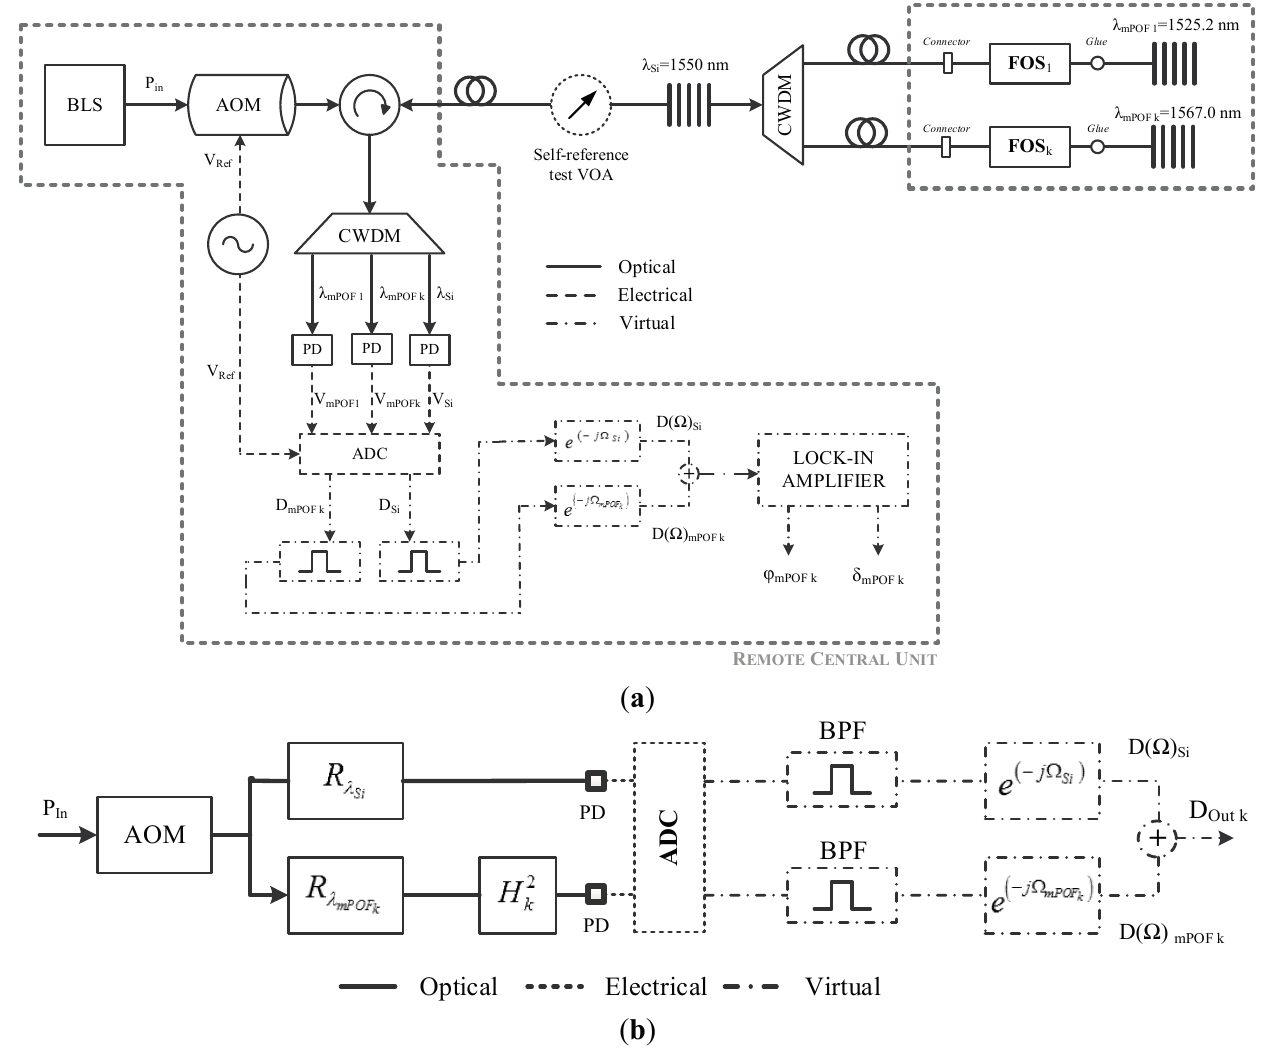
Figure 1. ( a ) Point-to-point self-referenced topology for generic remote sensing points; ( b ) Filter model of the configuration for a single remote sensing point including DAQ, bandpass filters (BPF) and virtual